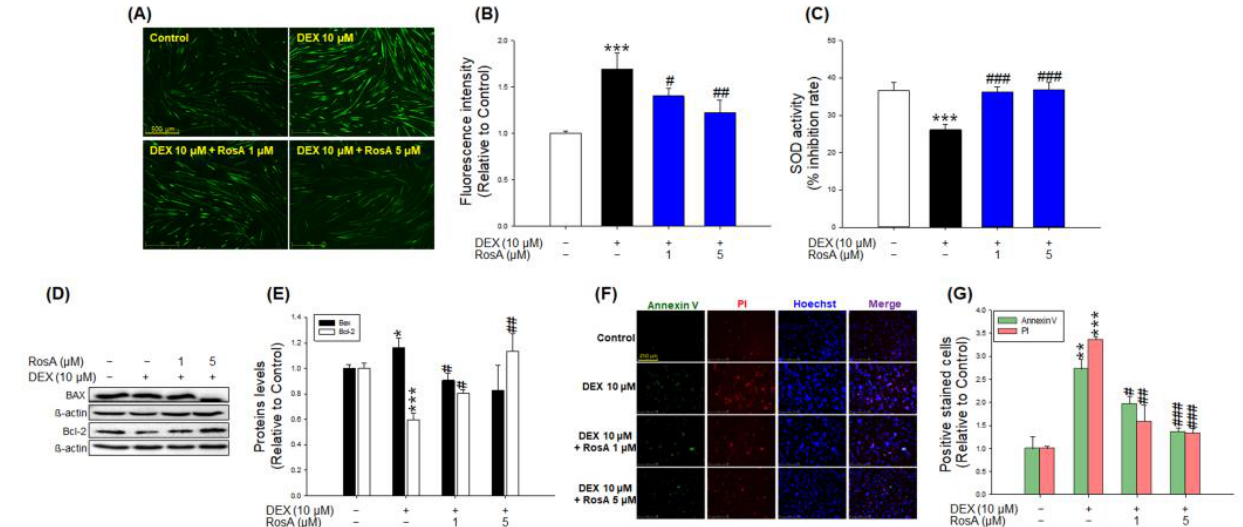
Figure 4. Effects of RosA on ROS production and expression of an apoptosis-related protein in atrophy-induced C2C12 by DEX treatment. ( A ) The production of cellular ROS analysis using a 2,7-dichlorodihydrofluorescein diacetate (DCFH-DA) dye and observed under a fluorescence micro- scope (scale bar = 500 µ m). ( B ) The graph shows the quantification of the CM-H 2 DCFDA-stained area using the ImageJ software program (1.48 version). ( C ) The antioxidant enzyme (SOD) activity. ( D ) The expression of BAX and Bcl-2 was detected by western blotting analysis. ( E ) The quantitative of BAX and Bcl-2 expression levels. ( F ) Annexin V, PI, Hoechst staining of C2C2 myotubes (scale bar = 250 μm) . ( G ) The graph presents Annexin V-positive and PI-positive myotubes. These results are presented as the means ± SD of three independent experiments: * p < 0.05, ** p < 0.01, *** p < 0.001 vs. control; # p < 0.05, ## p < 0.01, ### p < 0.001 vs. DEX.